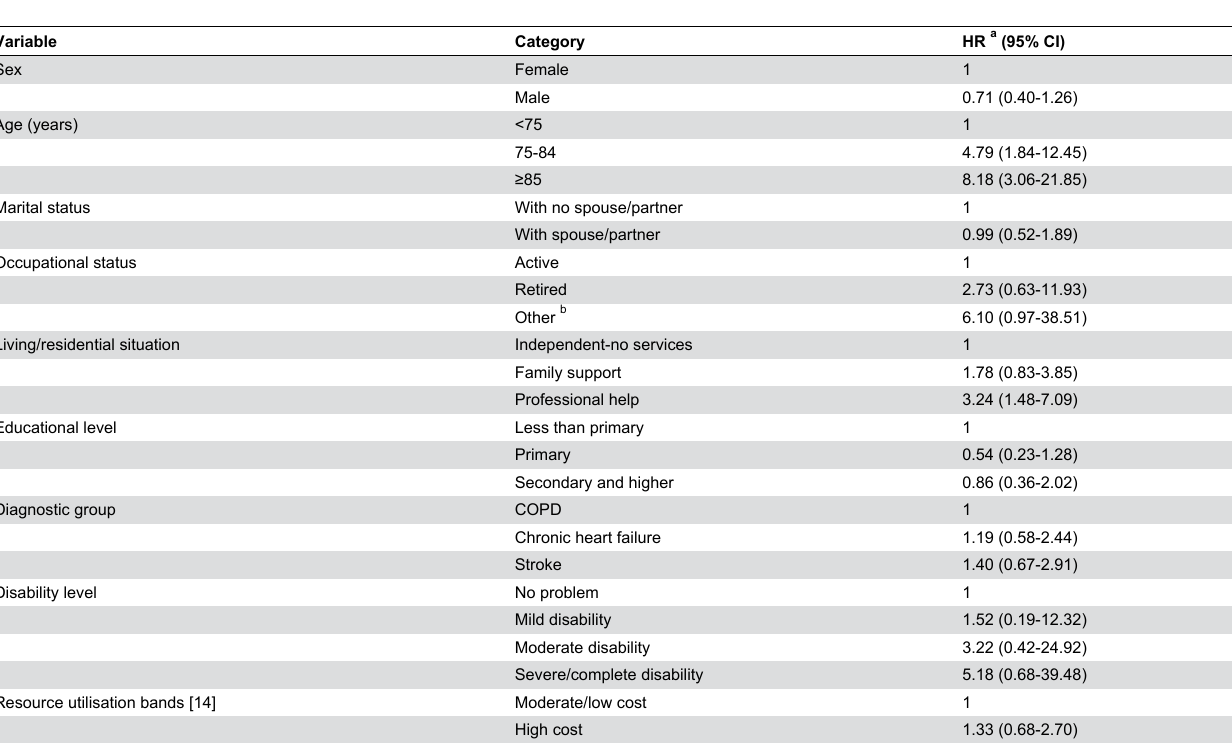
Table 2. Mortality hazard ratios for demographic and disability variables.